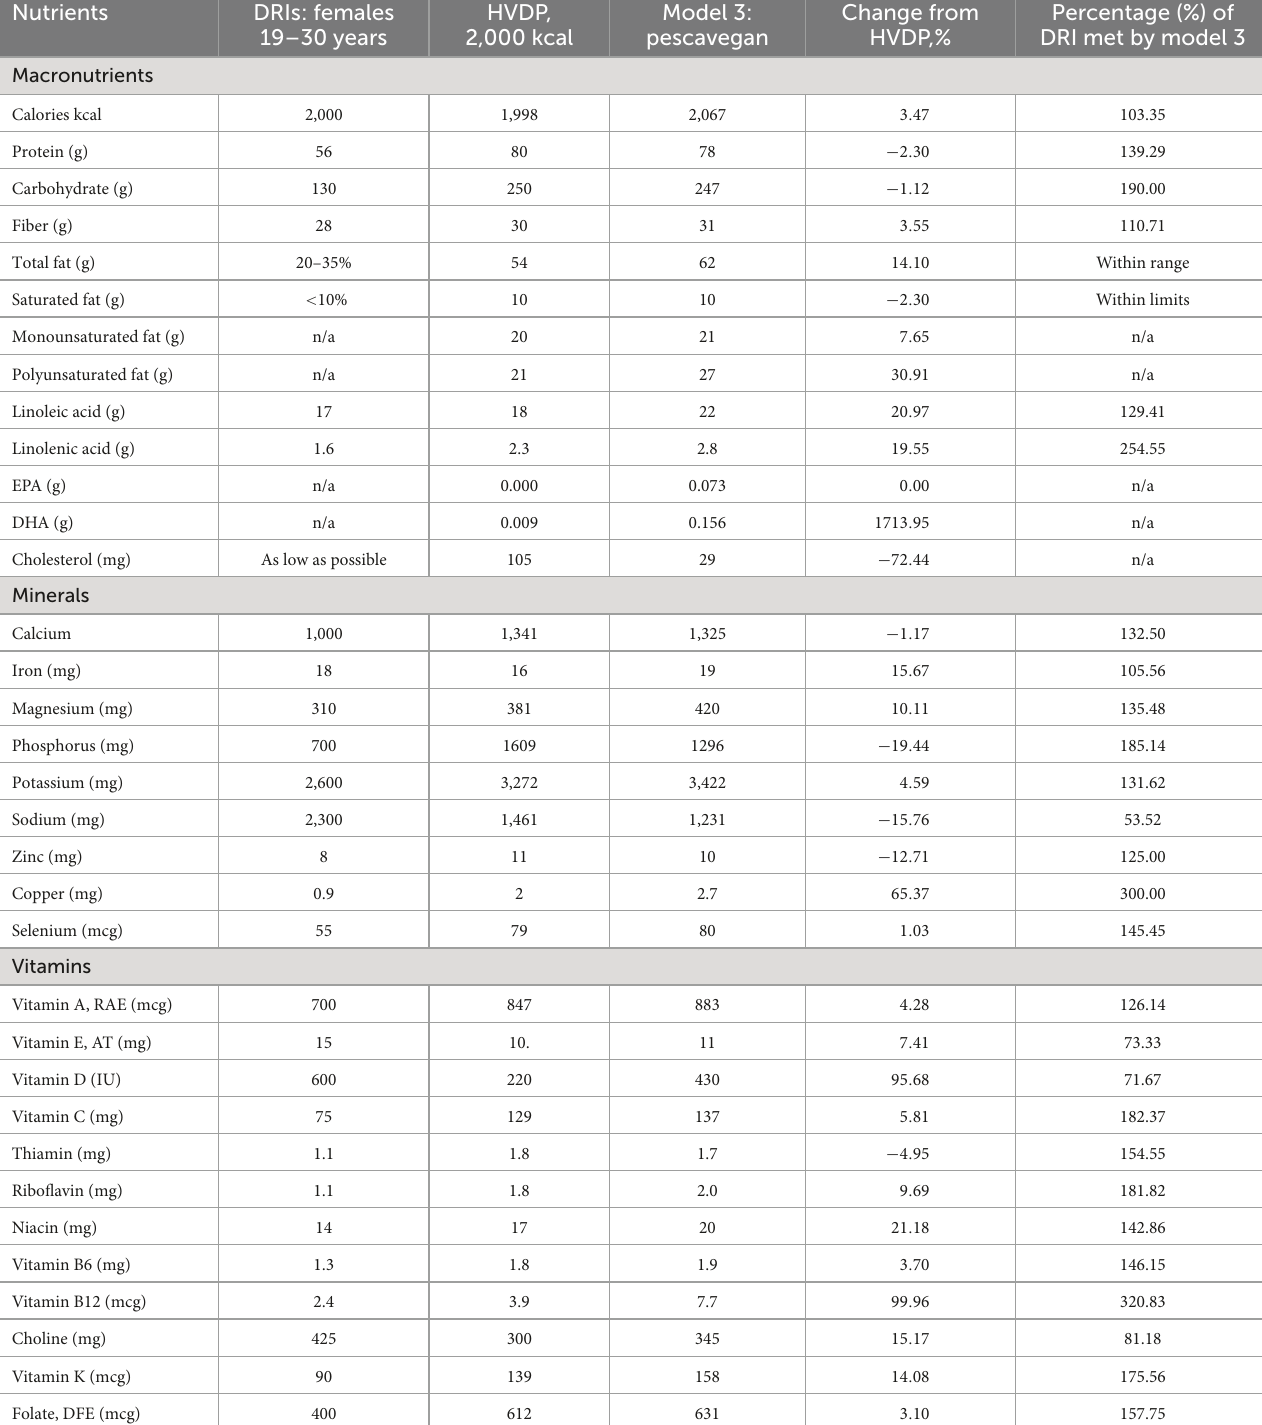
TABLE 6 Impact of adding fish to the 2,000 kcal/d vegan adaptation of the Healthy Vegetarian Dietary Pattern (HVDP) on Dietary Reference Intakes (DRIs) for females 19–30 y. Nutrients DRIs: females